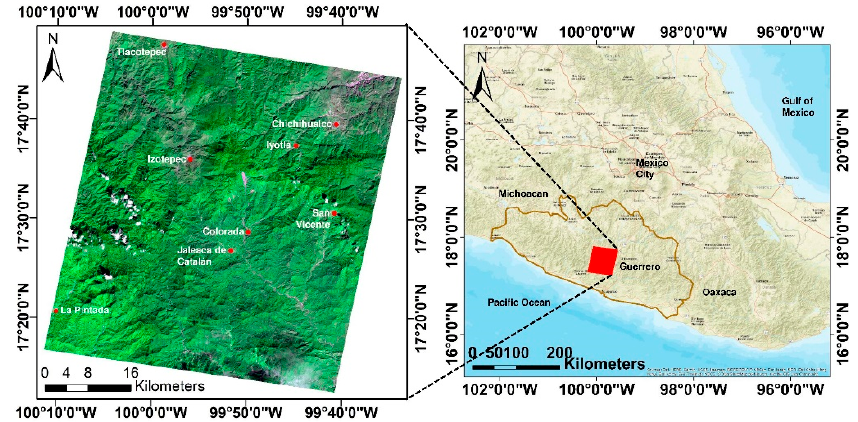
Figure 1. Study area: the central part of Guerrero State in México.